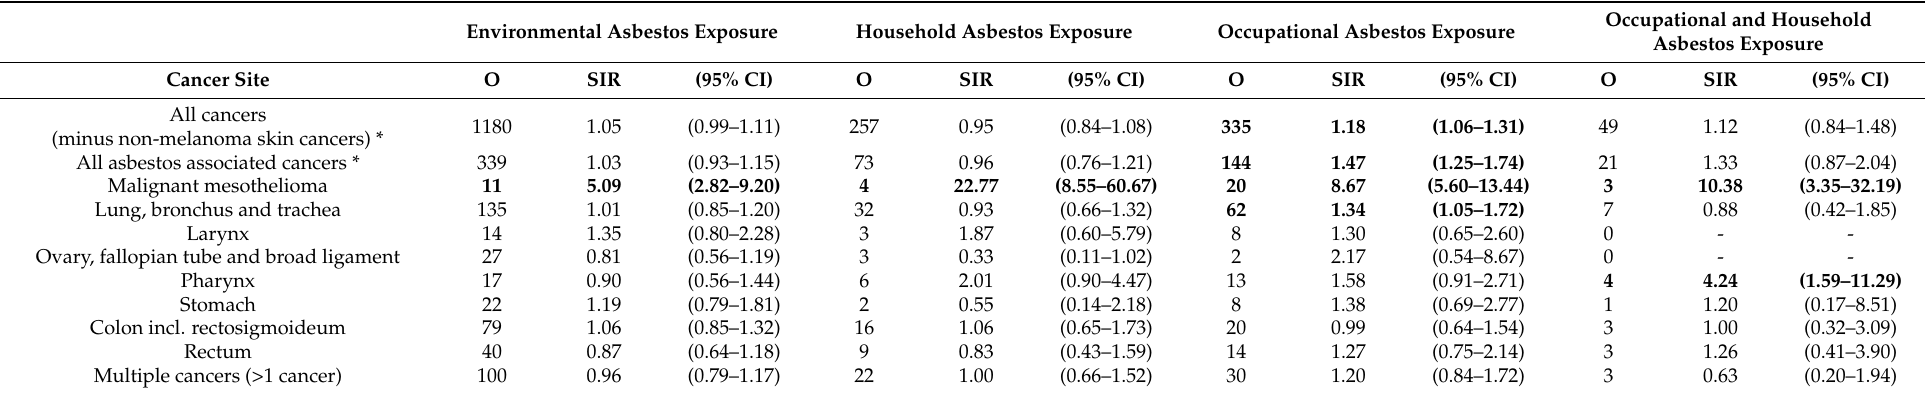
Table 3. Standardized incidence ratios (SIR) for selected cancers among those in the school cohort exposed only to environmental asbestos and the subgroups also exposed to household or/and occupational asbestos